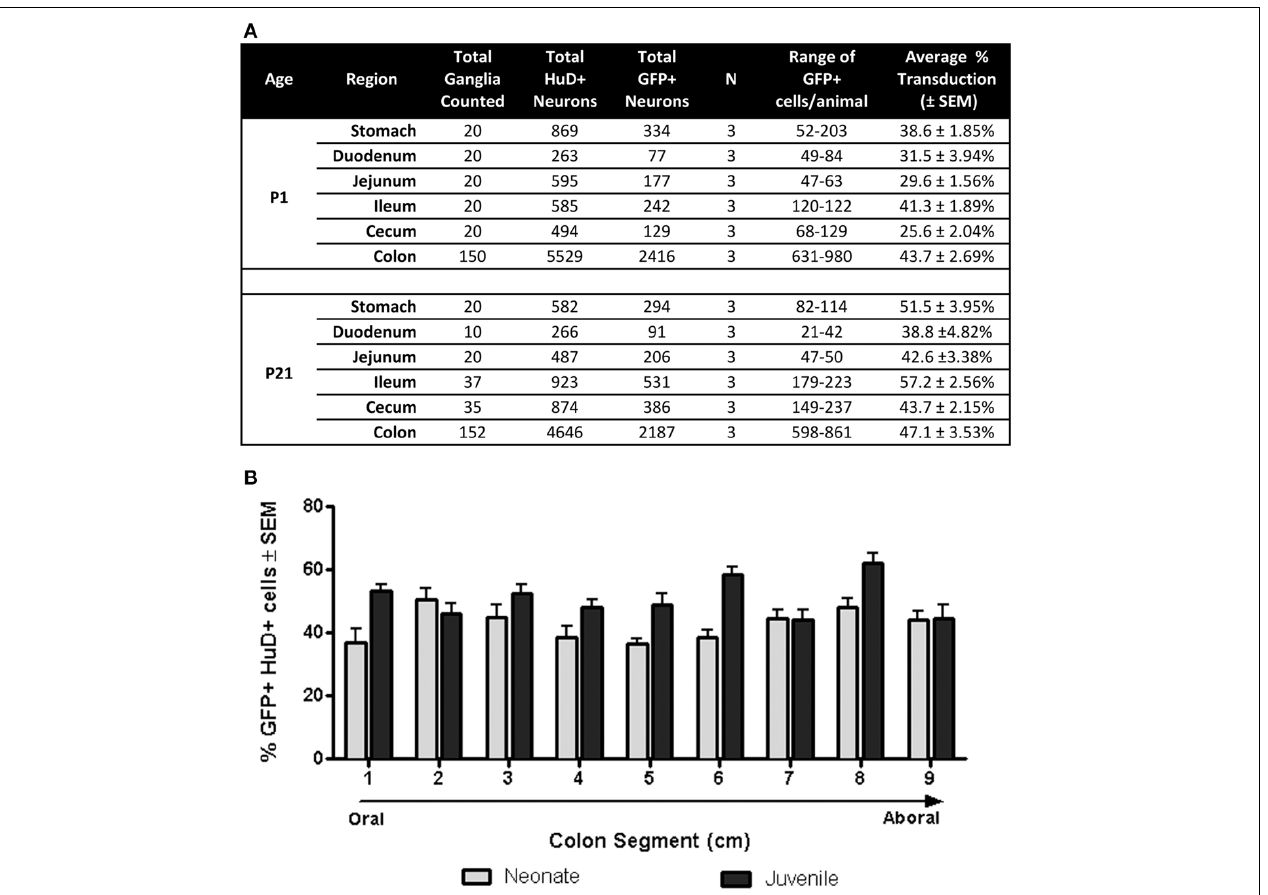
FIGURE 3 | Quantification of GFP expressing myenteric neurons. (A) Total transduced and untransduced neuron counts in each gastrointestinal region in mice injected either at P1 (neonates, n = 3) or P21 (juveniles, n = 3). Transduction of HuD positive neurons ranged from ∼ 25 to ∼ 43% in